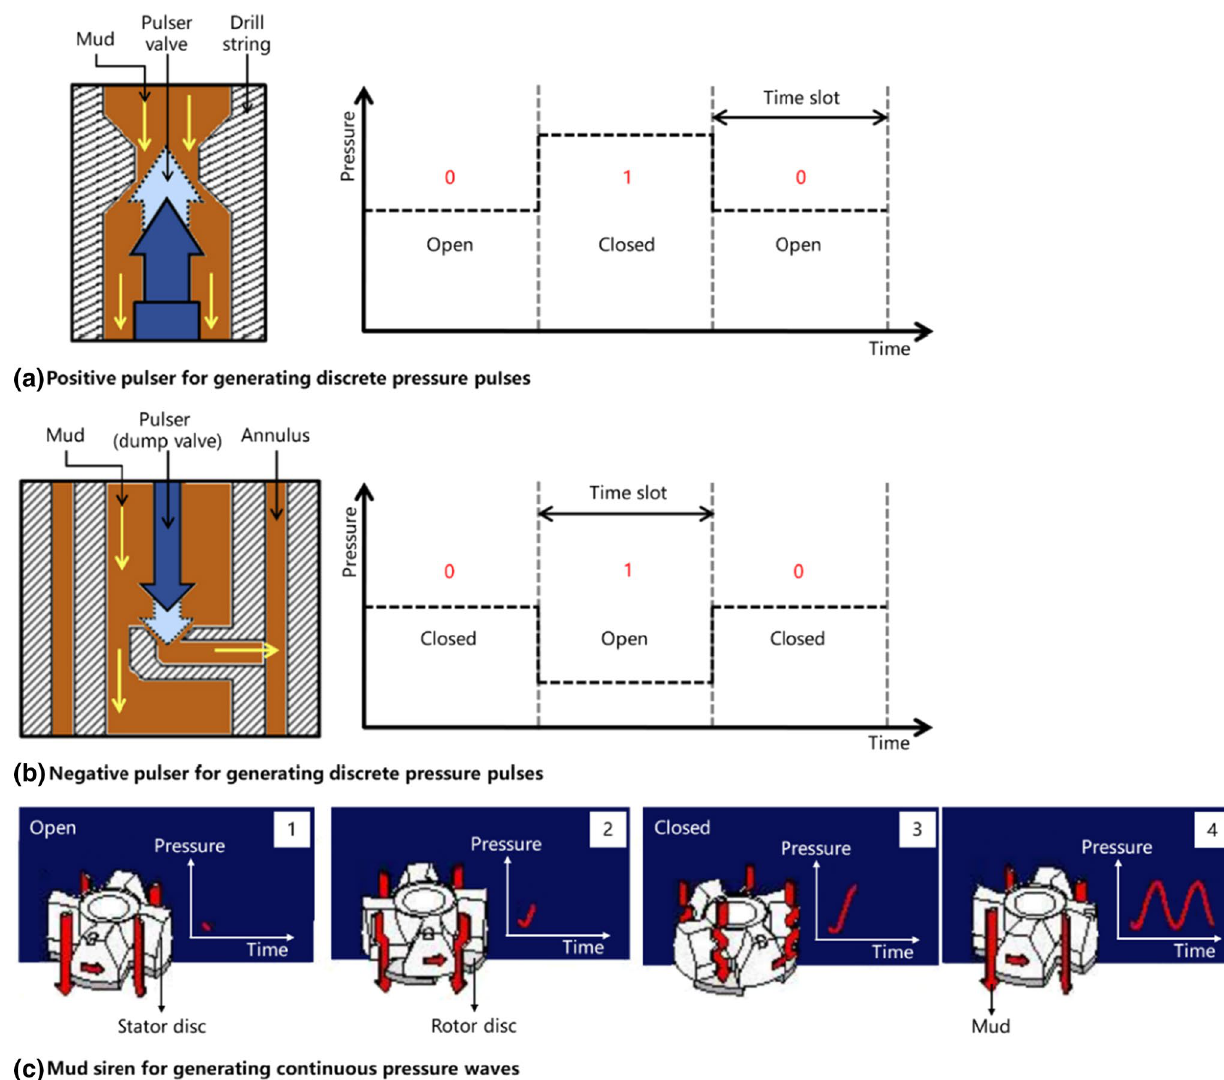
Fig. 18 Three kinds of mud pulse telemetry methods (Caruzo et al. 2012; Berro and Reich